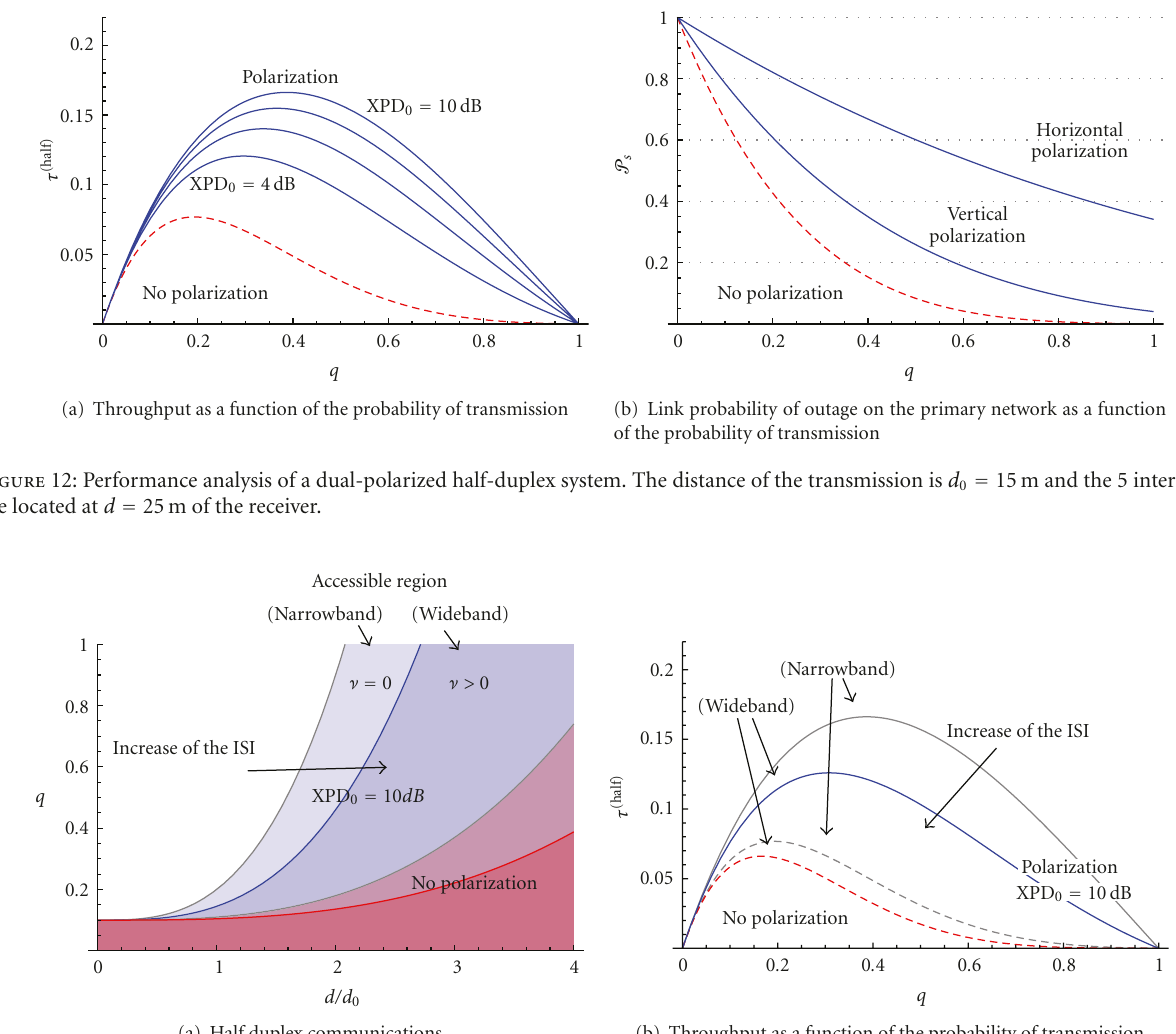
(b) Throughput as a function of the probability of transmission Figure 13: Impact of the channel fading on the system-level performance. The parameter value ν = 0 and ν > 0 correspond to narrowband scenarios and wideband scenario,